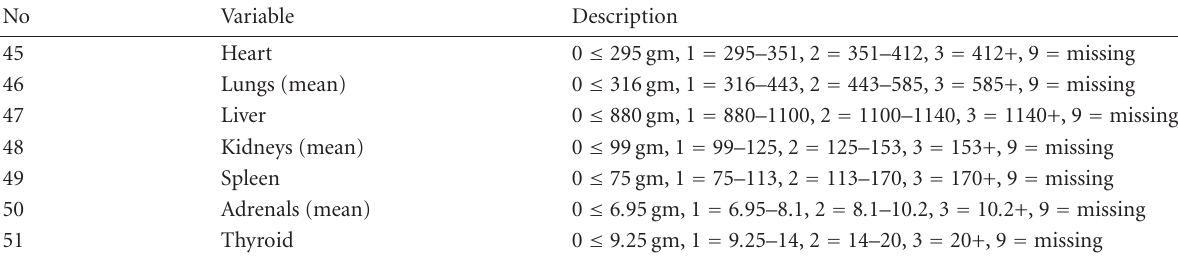
Table 3. The quartiles for organ